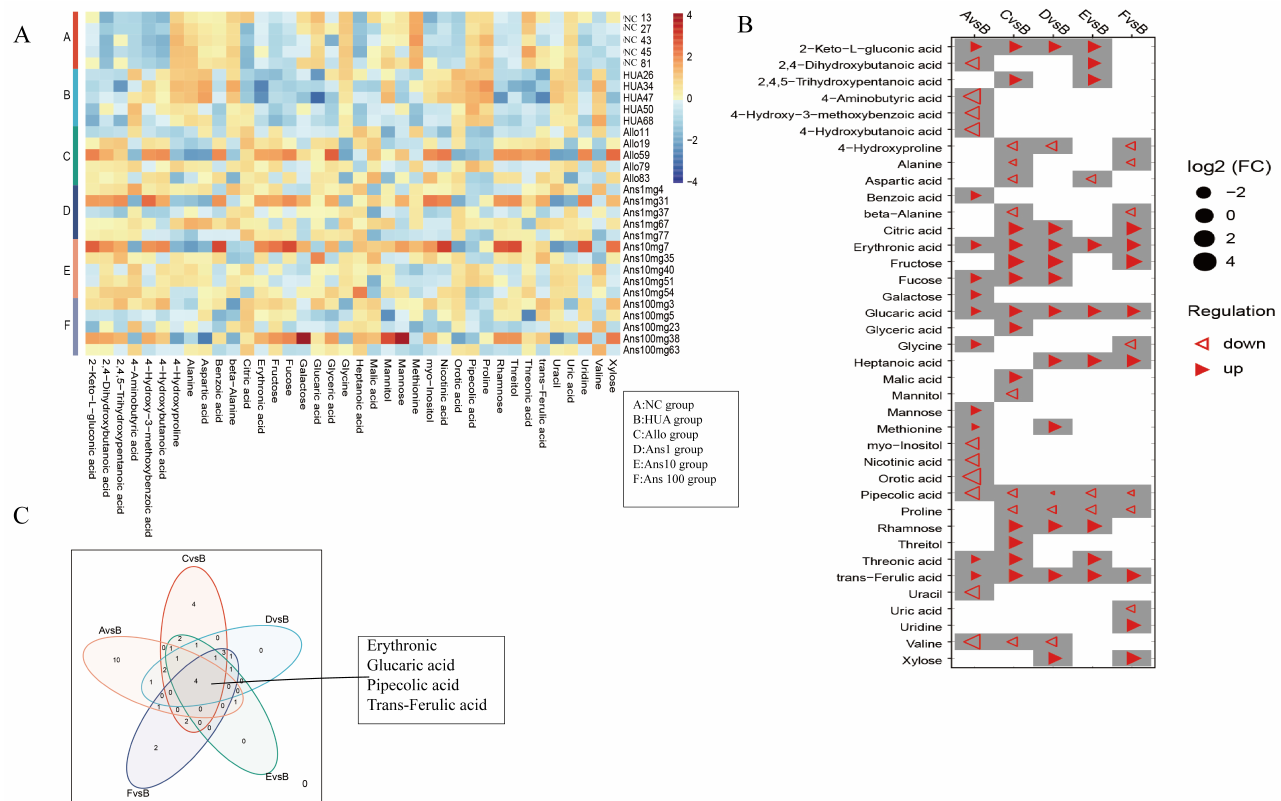
Figure 8. Differential urine metabolites among groups: ( A ) the heatmap of the relative level of 38 differential metabolites in each group; ( B ) the trend changes for 38 differential metabolites in five comparison groups; ( C ) the Venn diagram shows common metabolites for the five comparison groups ( p < 0.05).